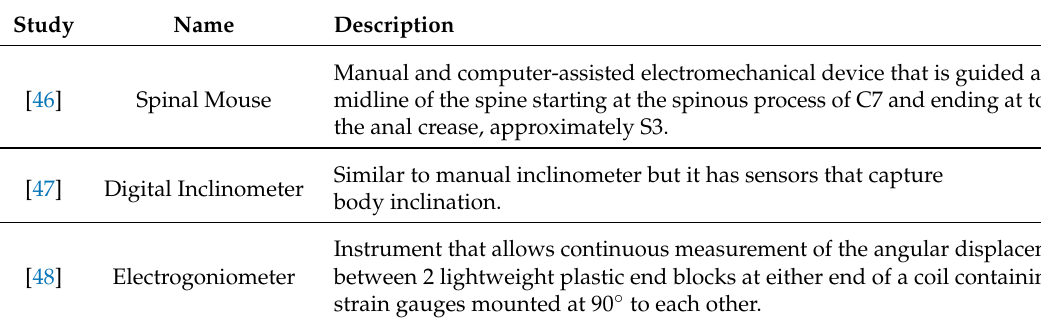
Table 2. Summary of digital assessment tools for human postural